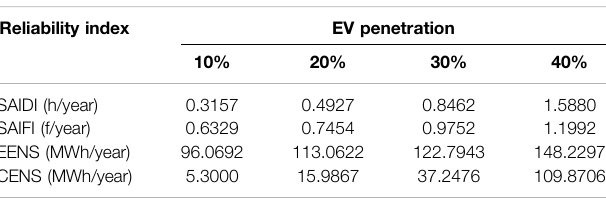
TABLE4| ReliabilityindexeswithincreasedbatteryEVcapacitybasedondifferent EV penetration. Reliability